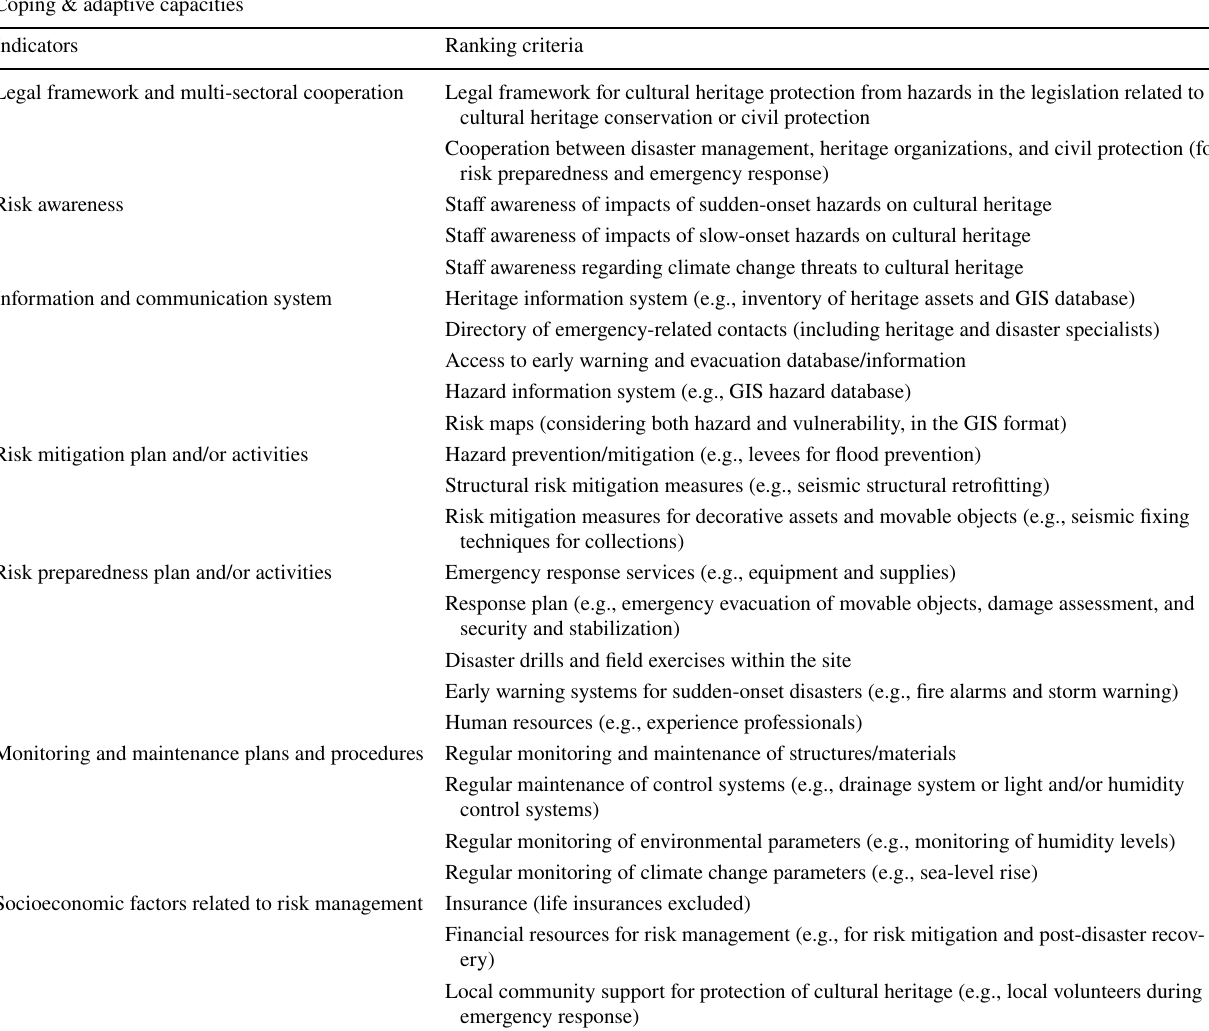
Table 5 Indicators for assessing coping and adaptive capacities Coping & adaptive